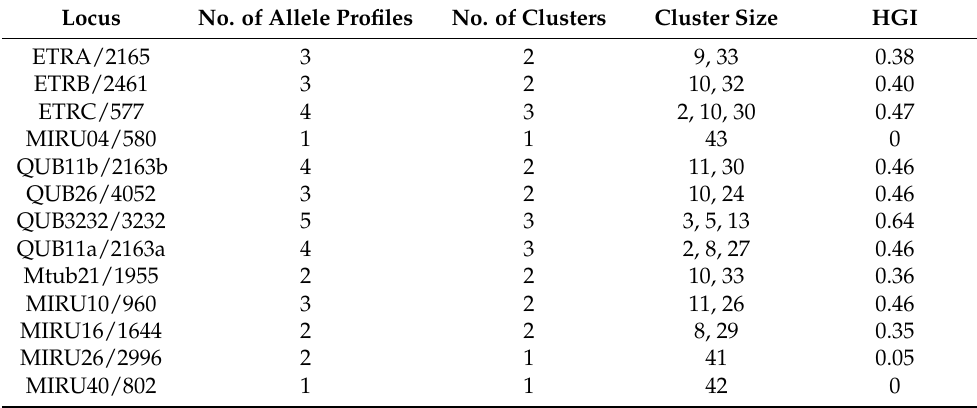
Table 1. Diversity of VNTR loci in M. bovis / M. caprae (all collection) from Bulgaria. Locus No. of Allele Profiles No. of Clusters Cluster Size HGI ETRA/2165 3 2 9, 33 0.38 ETRB/2461 3 2 10, 32 0.40 ETRC/577 4 3 2, 10, 30 0.47 MIRU04/580 1 1 43 QUB11b/2163b 4 QUB26/4052 10, 24 0.46 QUB3232/3232 5 0.64 QUB11a/2163a 4 3 2, 8, 27 0.46 Mtub21/1955 2 2 10,